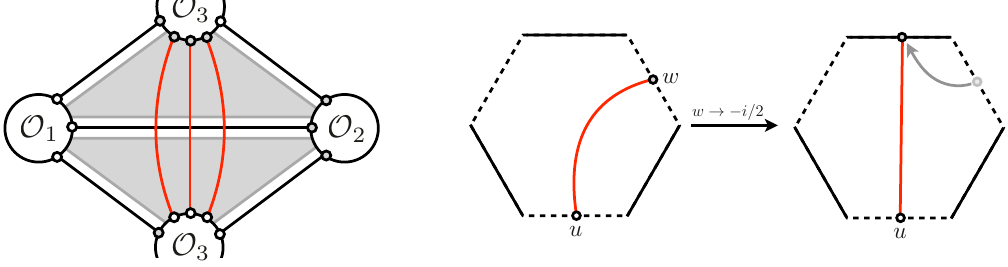
Figure 10 . Example of a (cid:12)shnet structure constant with magnons ending on the third operator. We can bring a mirror magnon to this position by continuing its mirror momentum to p ( w ) = 2 w = as shown in the right